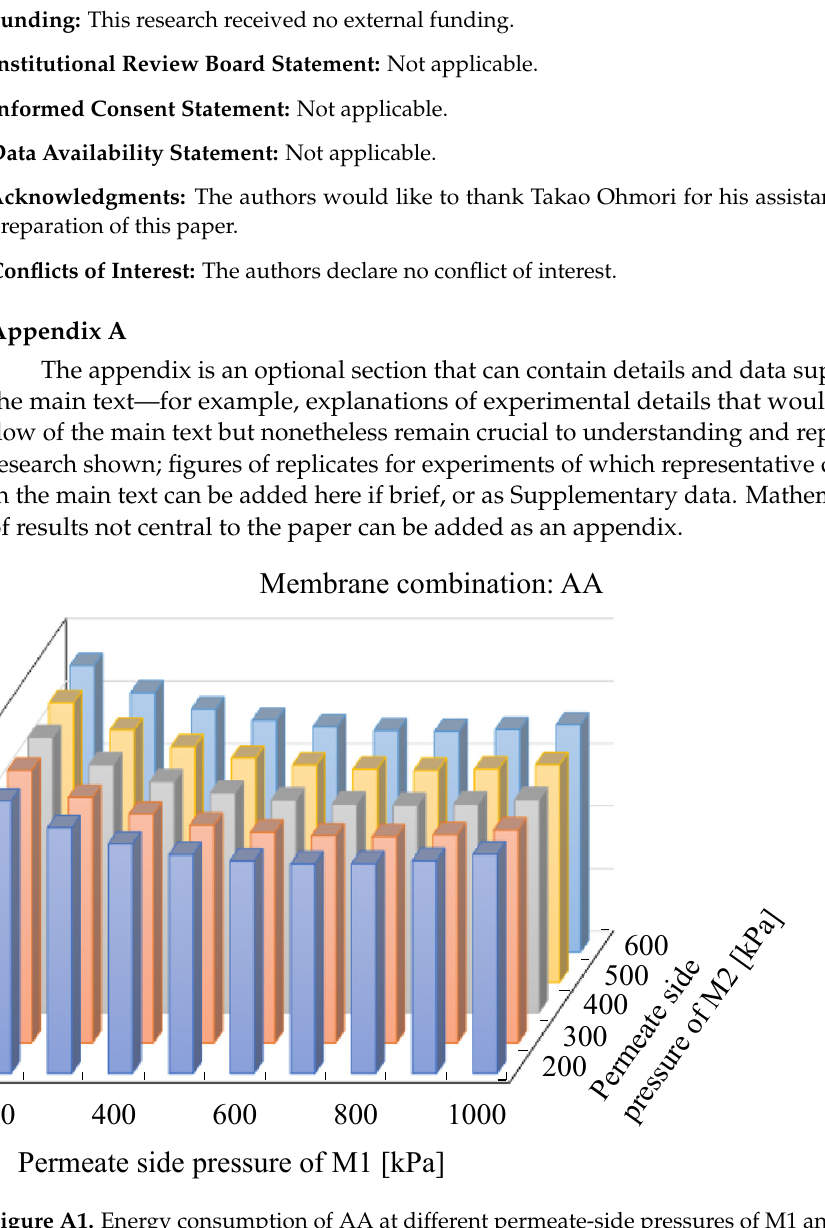
Table A1. Design and operating conditions at minimum energy consumption for the current mem- branes.